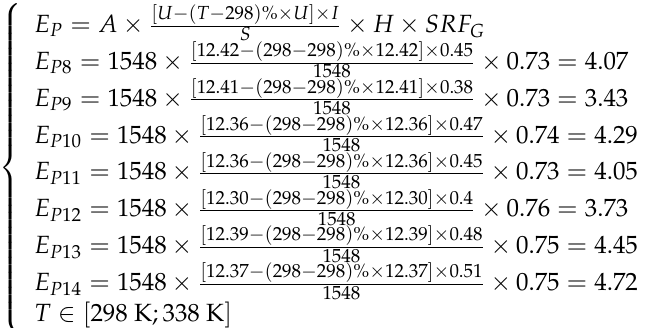
with the X-Axis representing the number of experimental days and the Y-Axis